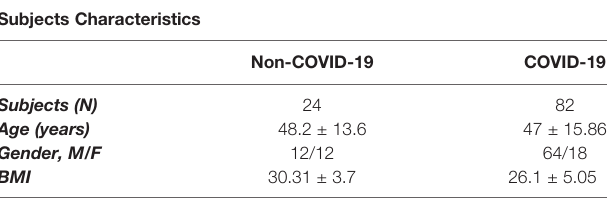
TABLE 1 | Summary of subjects characteristics enrolled in the study.